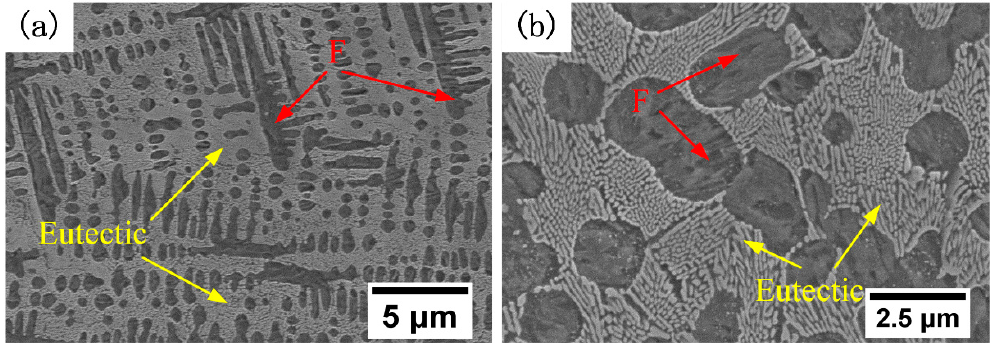
Figure 5. SEM micrographs of the deposited Fe–Cr–B–Si–Mo alloys. ( a ) Low- magnification; ( b ) high- magnification. ( b ) high-